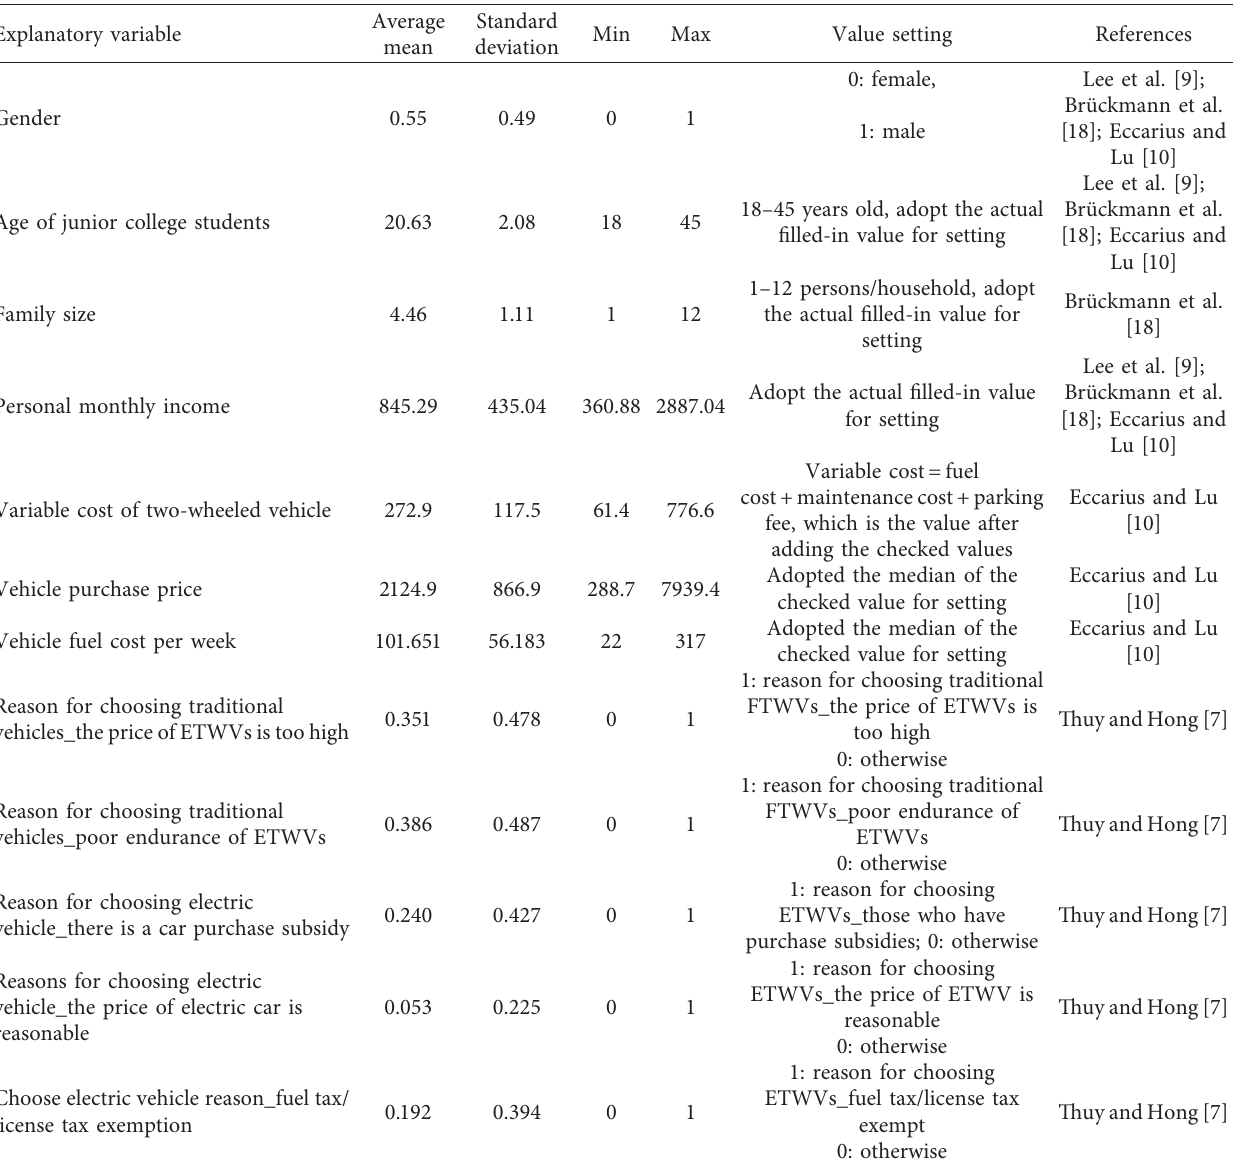
Table 6: Description of significant variables in the